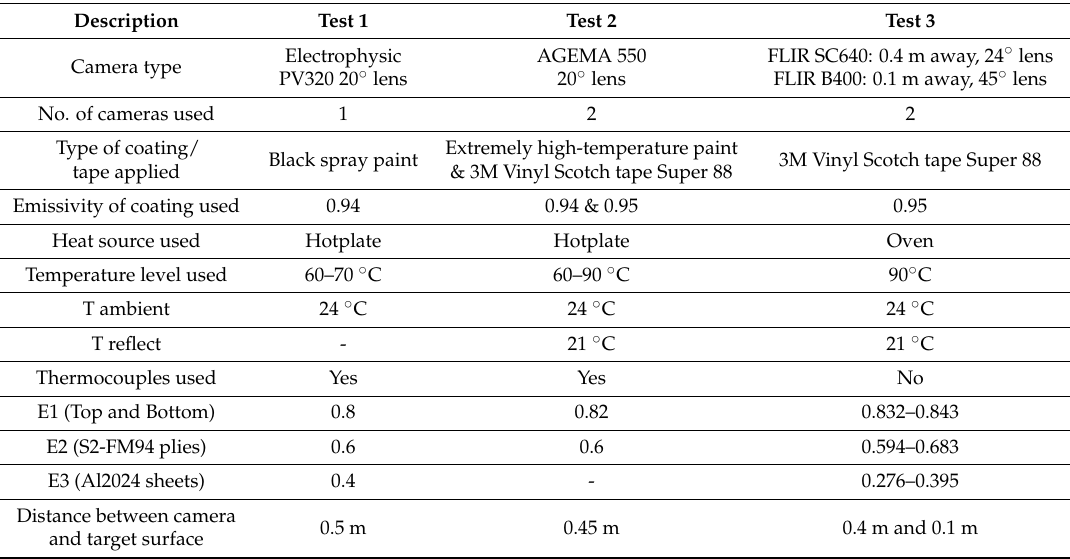
Table 4. Emissivity of GLARE fiber metal laminates using three IR cameras and thermocouple